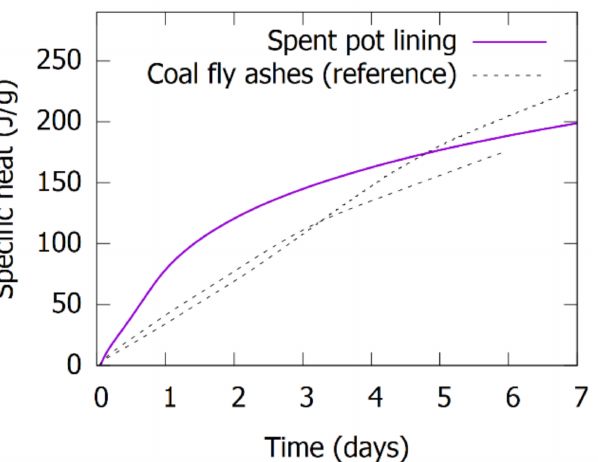
Figure 4. R3 heat release of the spent pot lining aluminosilicates determined using isothermal calorimetry compared to class F coal fly ashes as reference. Data for coal fly ashes was obtained from Snellings et al.